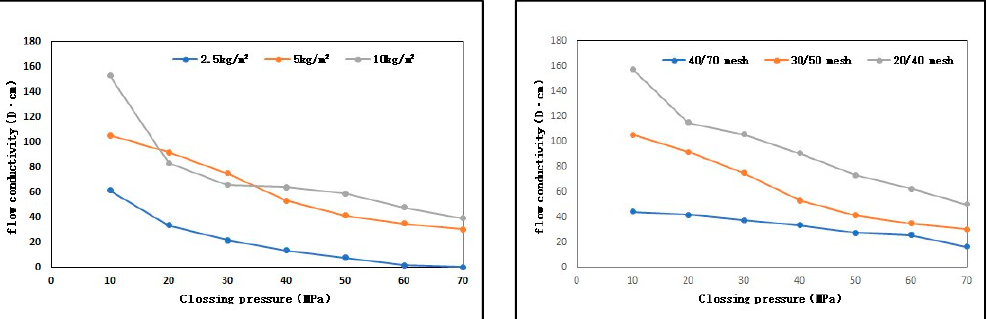
Figure 14. Proppant fracture conductivity curve under different particle sizes and sand concentration of saturated saline fracturing fluid.